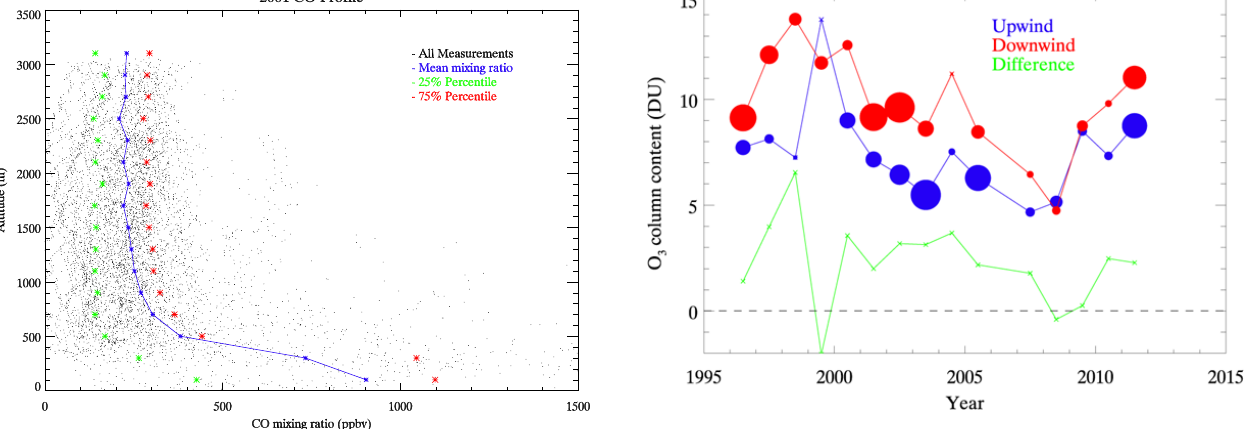
Fig. 8. Vertical distributions of tropospheric CO over the Balti- more/Washington region in 2001 (all spirals). The 25th percentile, mean, and 75th percentile are shown as in Fig. 7.